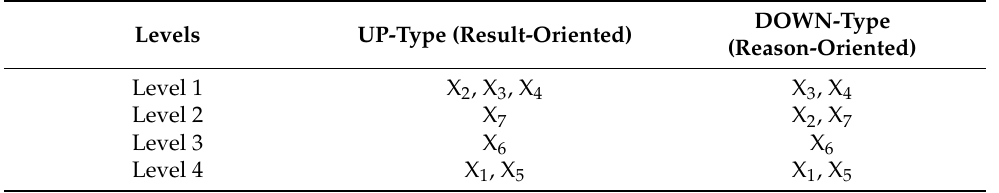
Table 7. Adversarial hierarchy extraction